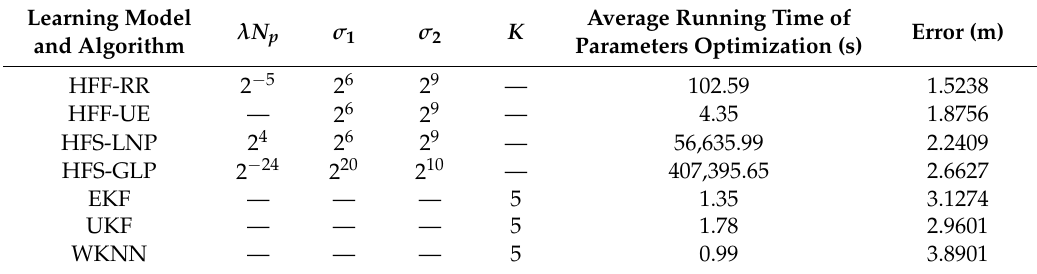
Table 2. Estimation error and computation complexity for different algorithms under TOA & RSS noise